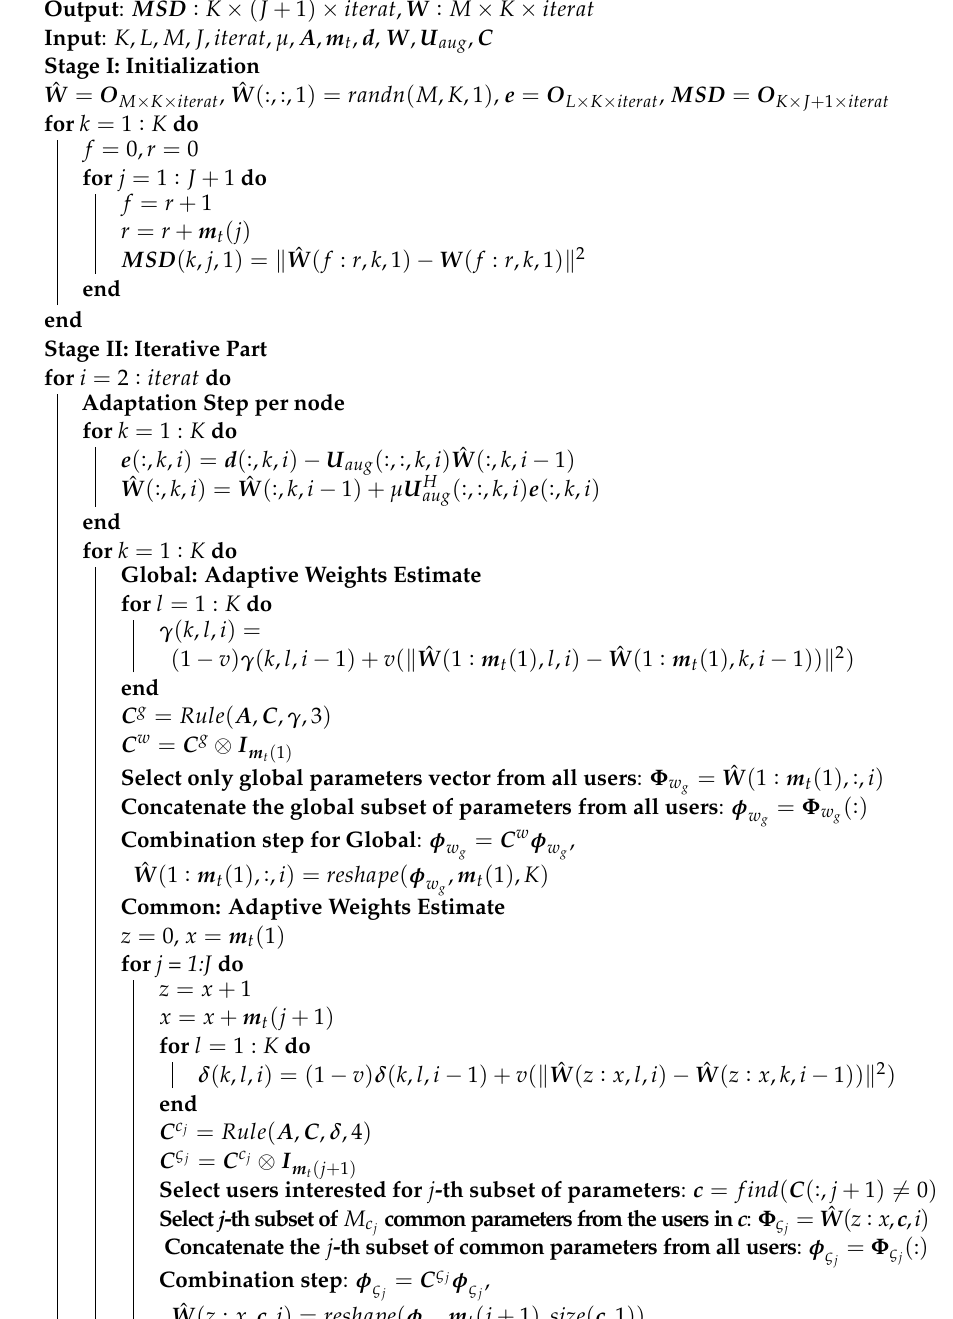
Algorithm 3: Diffusion-based Distributed Cooperative Method,